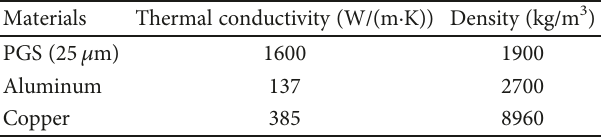
Table 2: Comparison of di ff erent material parameters.